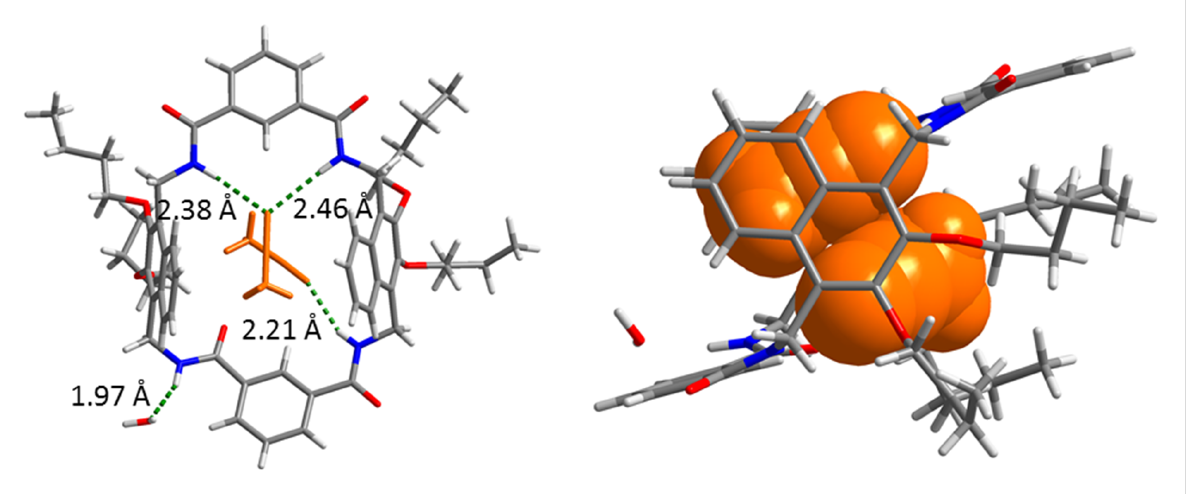
Figure 2: Two different views of the X-ray single crystal structure of 1 obtained from its CH 3 CN solution.